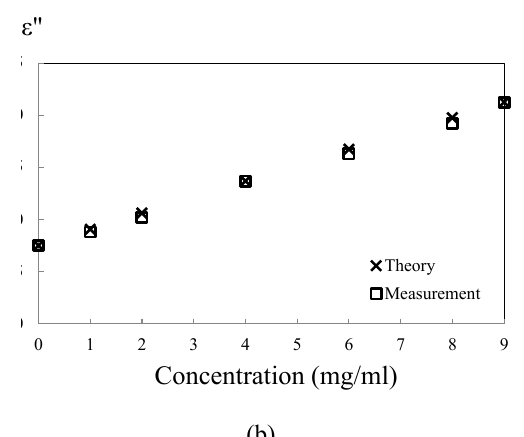
Figure 6: Theoretical and measured values of the dielectric permittivity for different NaCl aqueous solutions at 2 GHz: (a) real part ε’, (b) imaginary part ε”.